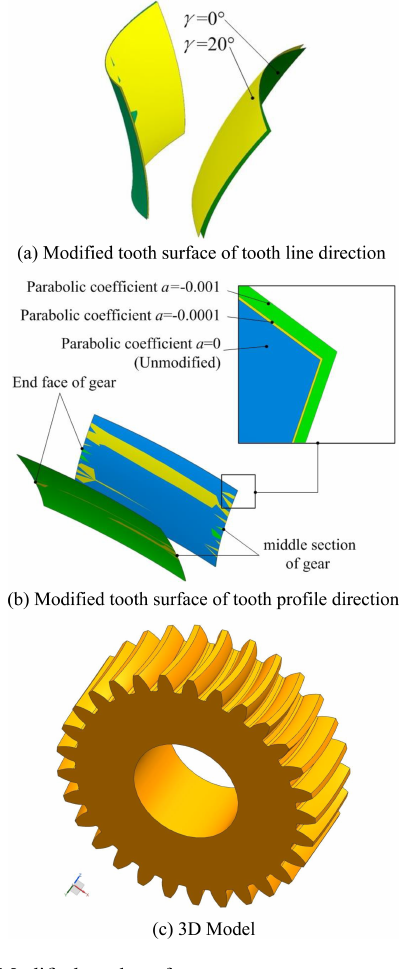
Figure 6. Modified tooth surface.